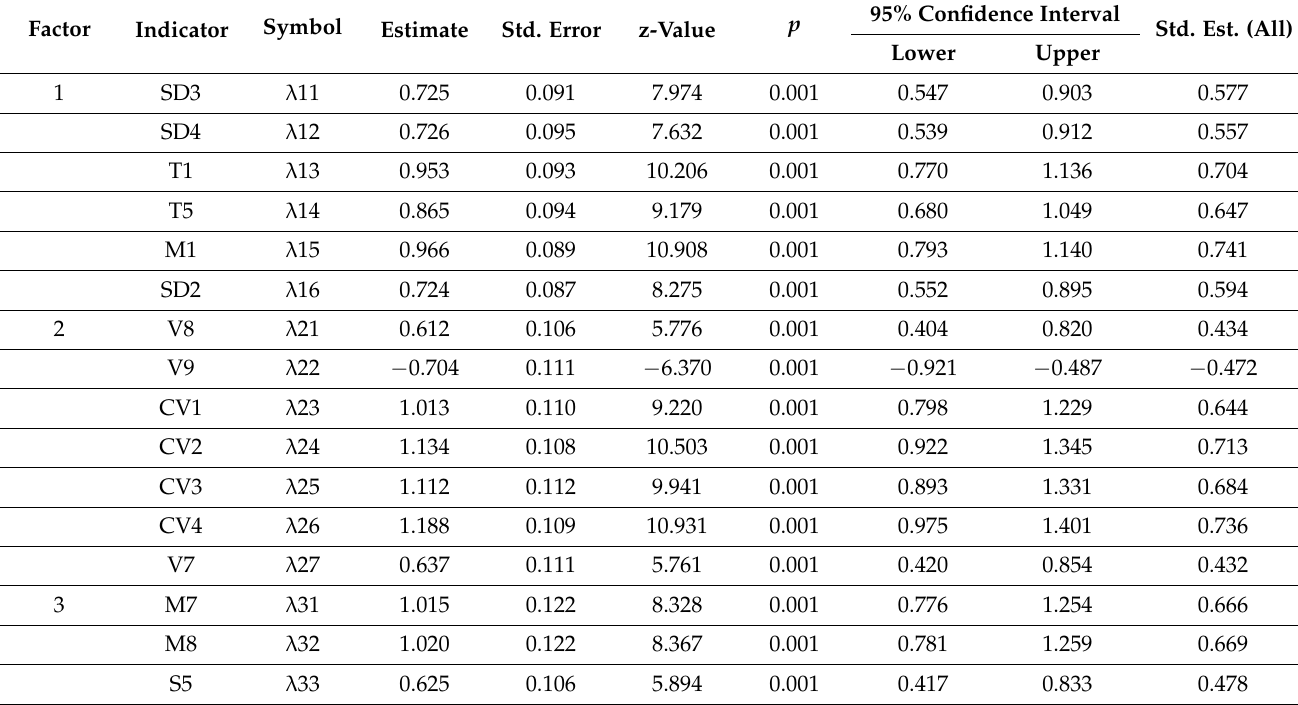
Table 6. Final model’s factor loadings.